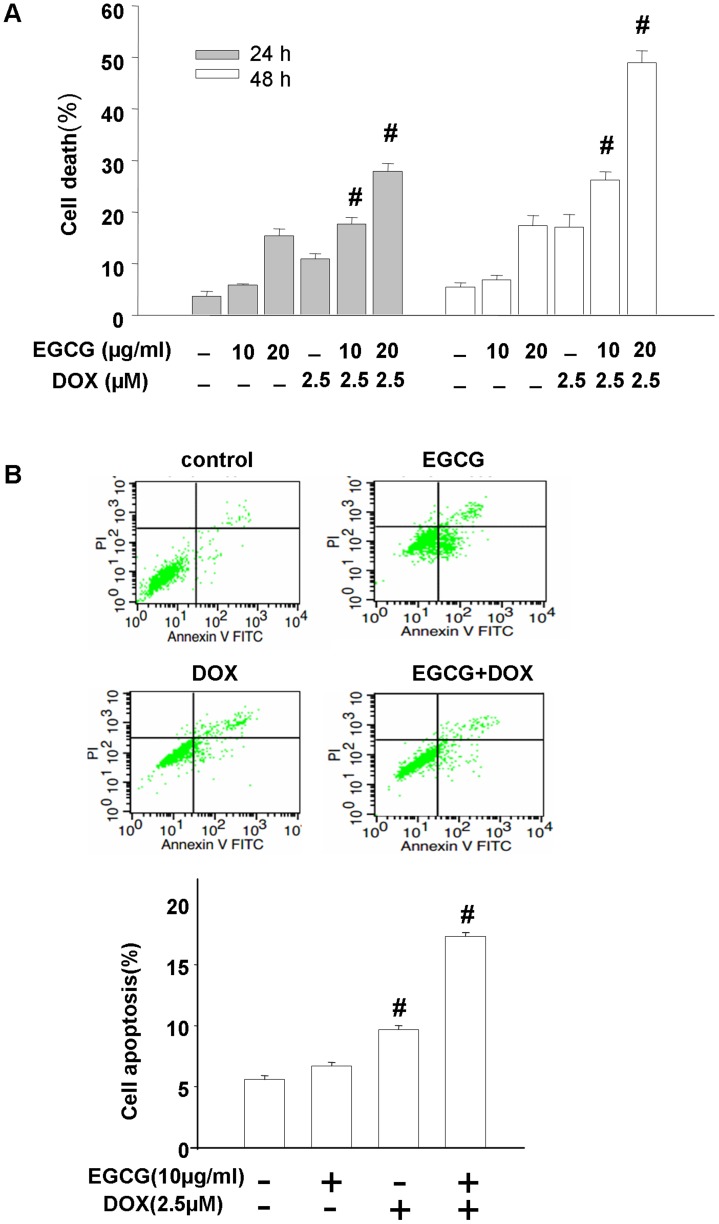
Combination of EGCG and DOX promoted cell death and apoptosis in Hep3B cells.(A) Trypan blue assay characterized the cell death of Hep3B cells treated with EGCG (10 µg/ml, 20 µg/ml) in the presence or absence of DOX (2.5 µM) for 24 h and 48 h. (B) Flow cytometry analyzed the apoptosis of Hep3B cells after addition of EGCG (10 µg/ml) in the presence or absence of DOX (2.5 µM) for 24 h. The lower panel is the summarized data. Results are representative of three independent experiments and error bars indicate SE. #p<0.01 vs. control.